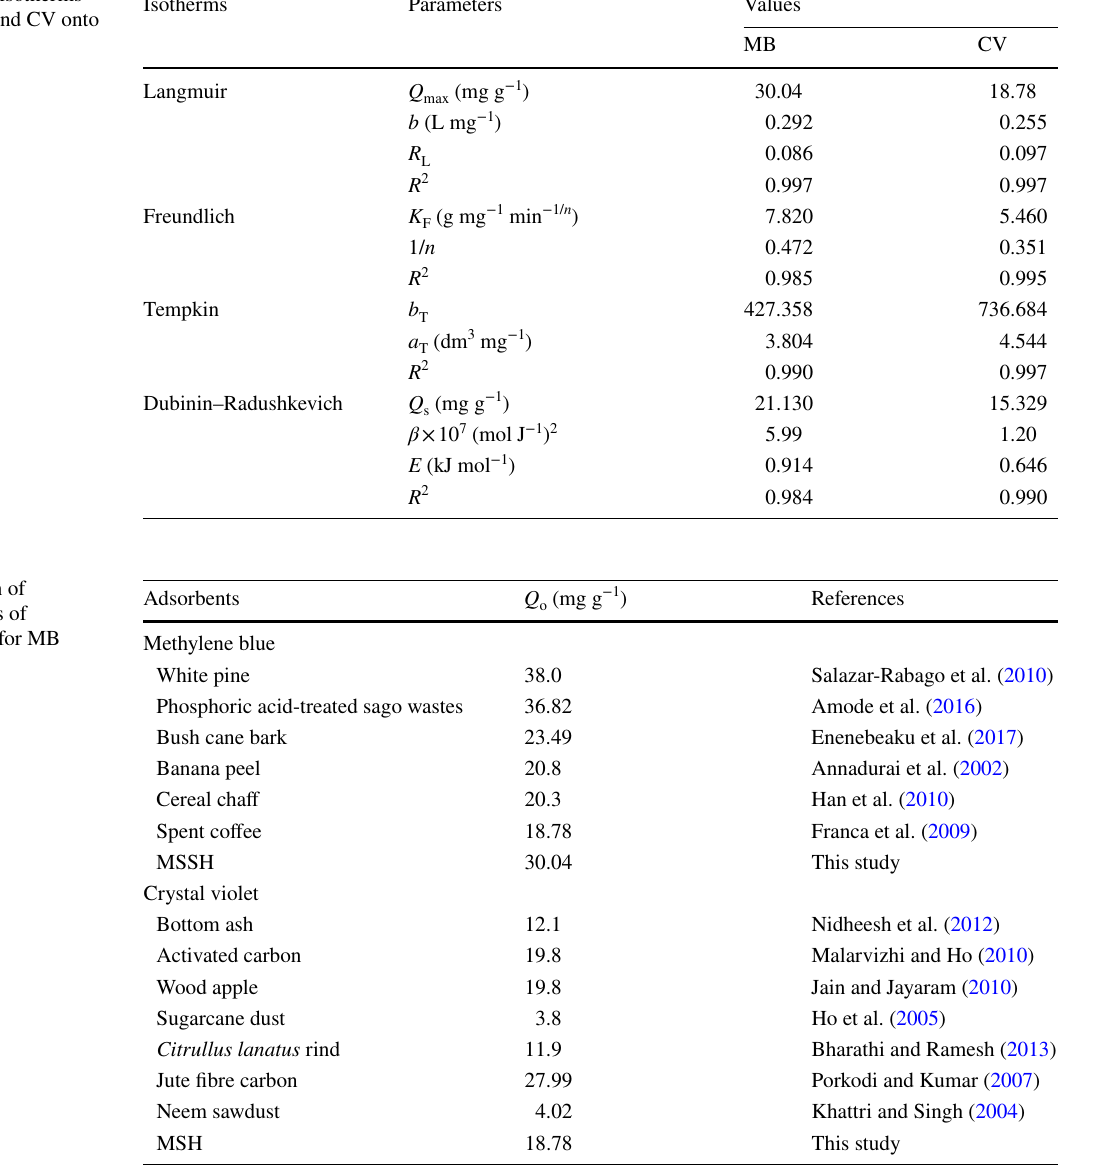
Table 6 Adsorption isotherms parameters for MB and CV onto MSH